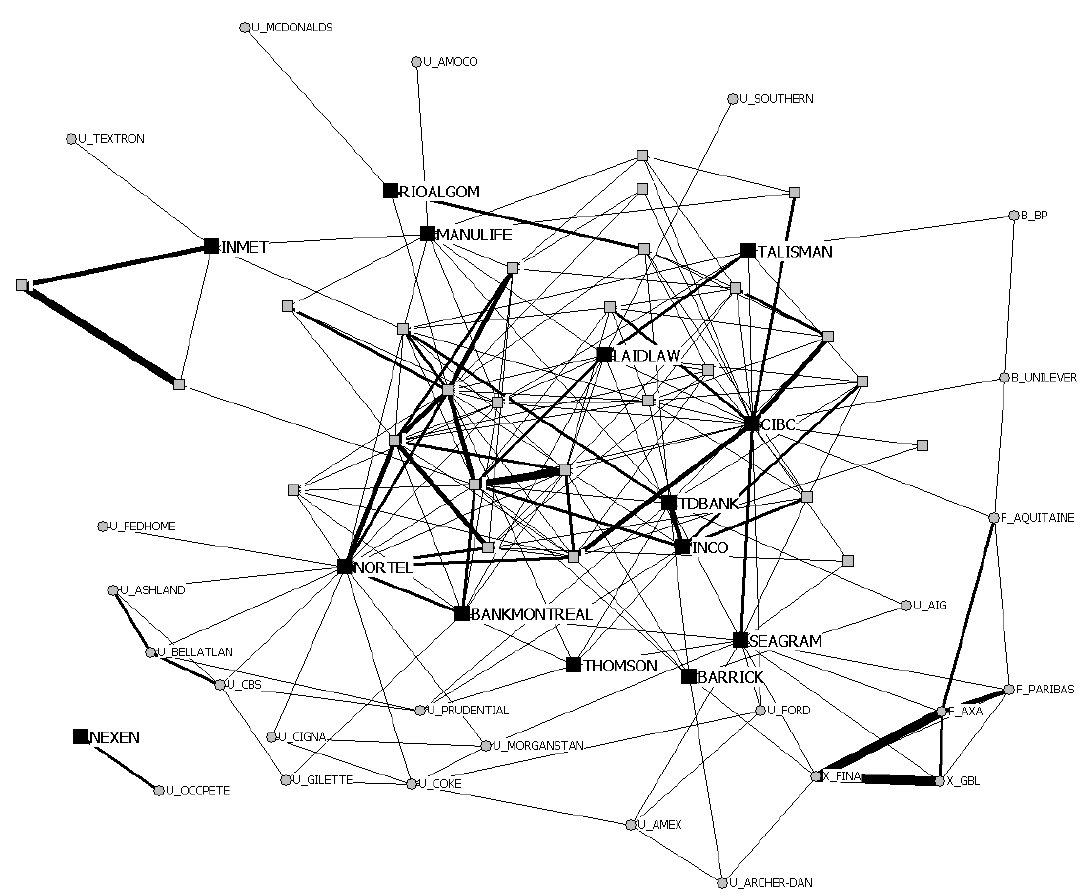
Figure 5. Interlocks among Canandian TNCs and non-Canadian G500 firms, 1996